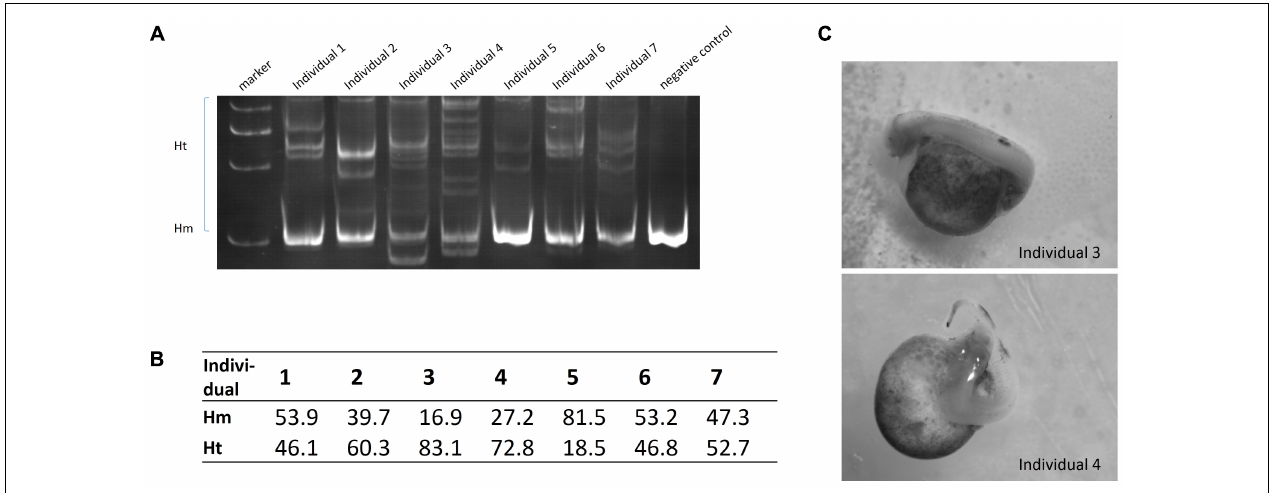
FIGURE 6 | (A) Detection of ntl gene mutation by PAGE. (B) Mutation rate (Ht%) of individuals. (C) Phenotype of ntl